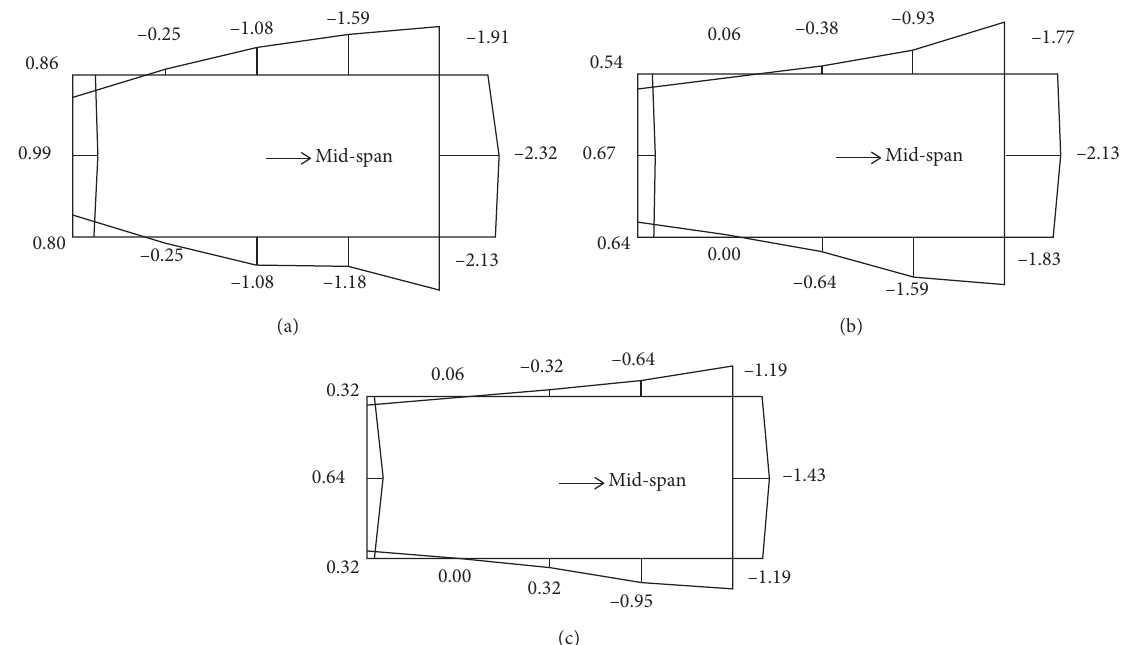
Figure 6: Stress distribution diagram of section no. 4 tower column under live load (unit: MPa). (a) Working condition 1, T1 section’s positive moment loading stress diagram. (b) Working condition 2, T2-1 section’s positive moment loading stress diagram. (c) Working condition 2, T2-2 section’s positive moment loading stress